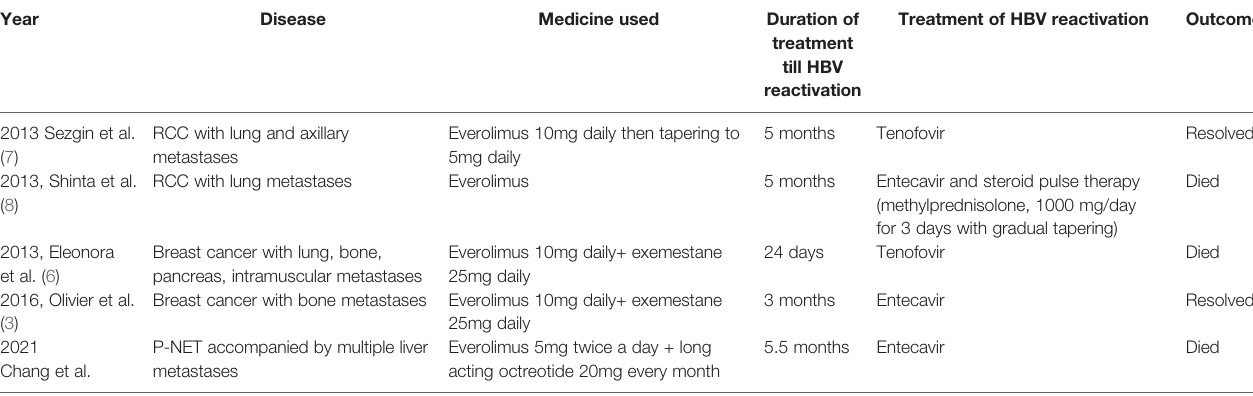
TABLE 1 | Case reports about everolimus related HBV